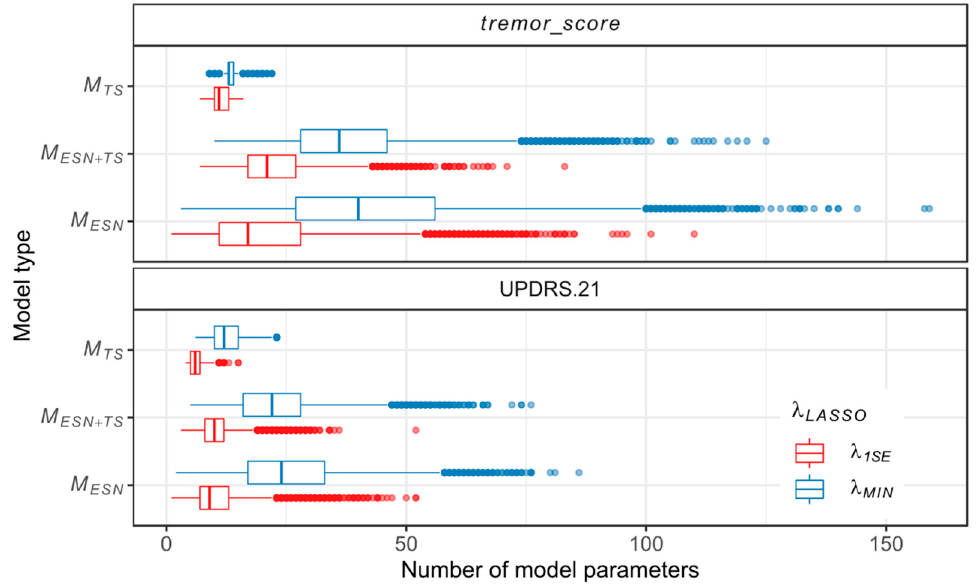
Figure 6. Total parameter counts of individual models, grouped according to the model type and λ LASSO regularization parameter.